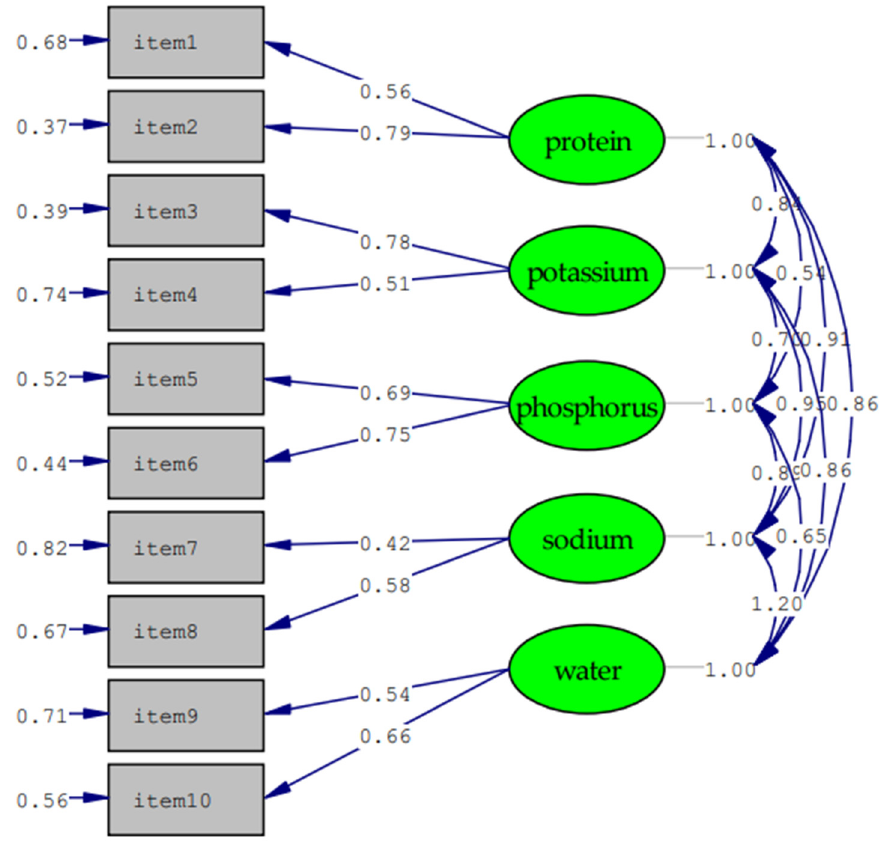
Figure 1. The structure of the hemodialysis dietary knowledge. Parameter estimates are standardized. Model fit indices: GFI = 0.96, AGFI = 0.90, RMSEA = 0.09, SRMR = 0.05, NFI = 0.96, CFI = 0.96, and PGFI = 0.43. Table 2. Psychometric properties of the hemodialysis dietary knowledge Scale ( n =